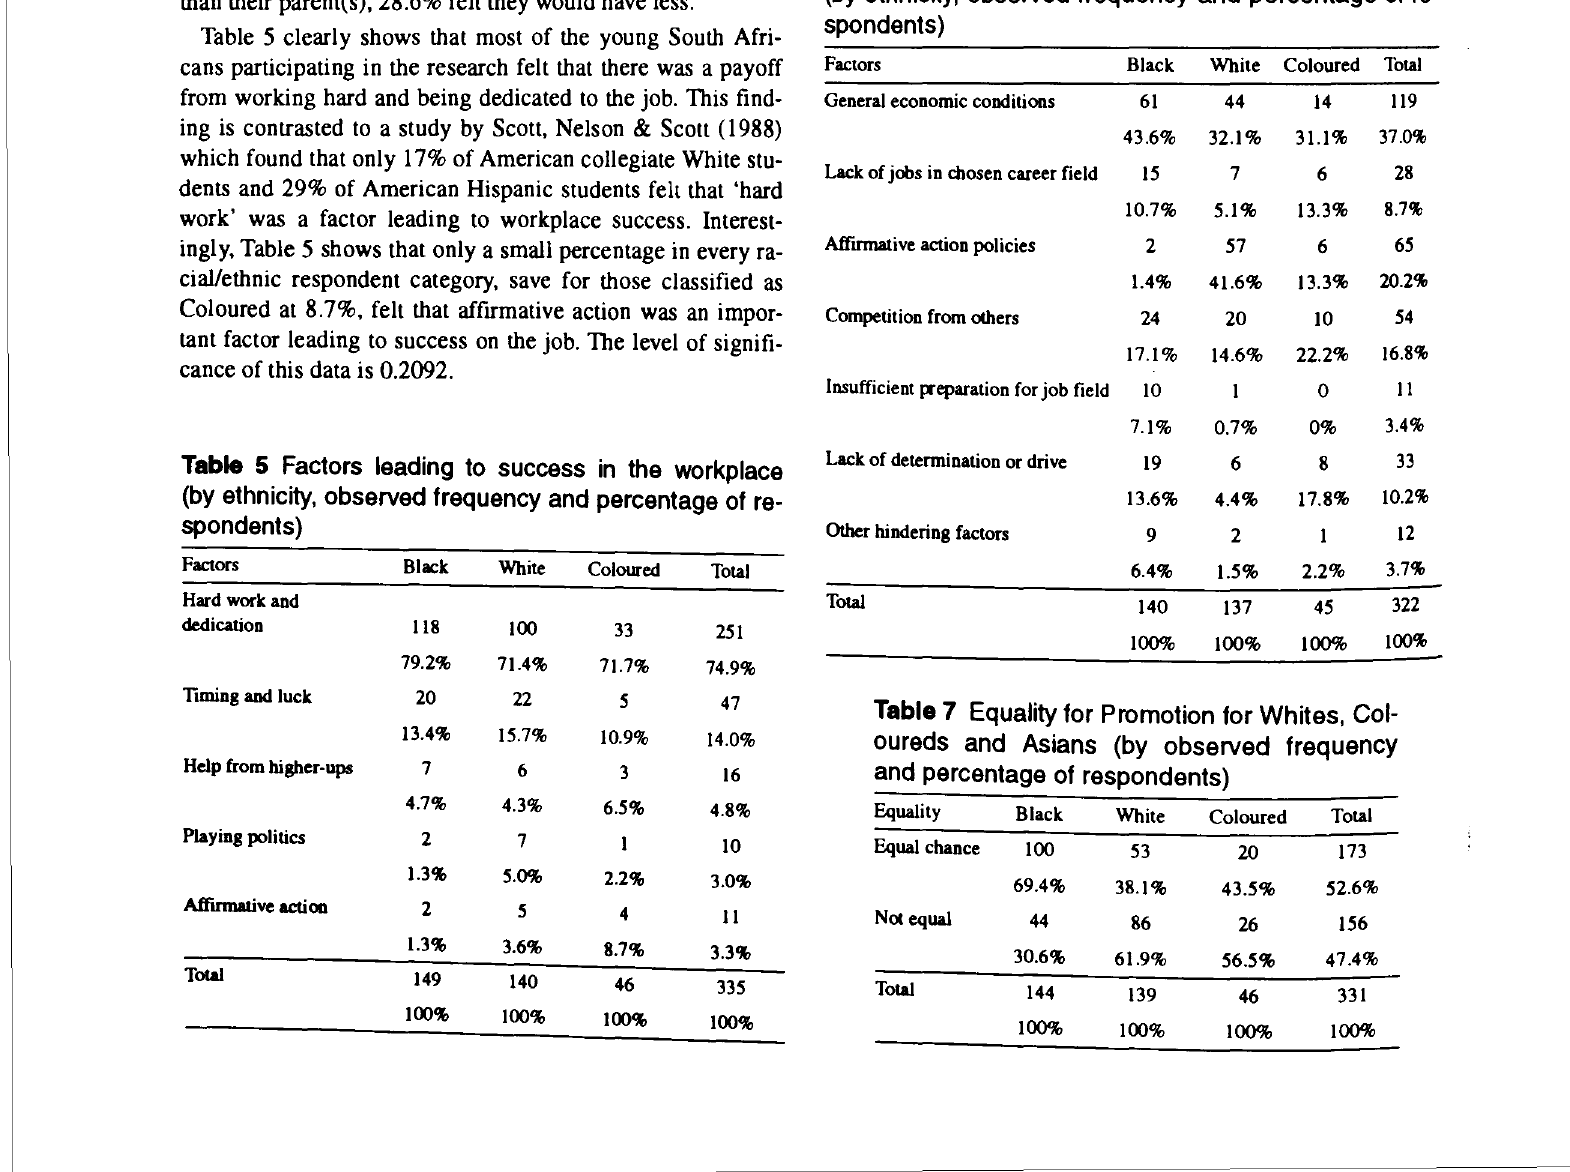
Table 7 Equality for Promotion for Whites, Col- oureds and Asians (by observed frequency and percentage of